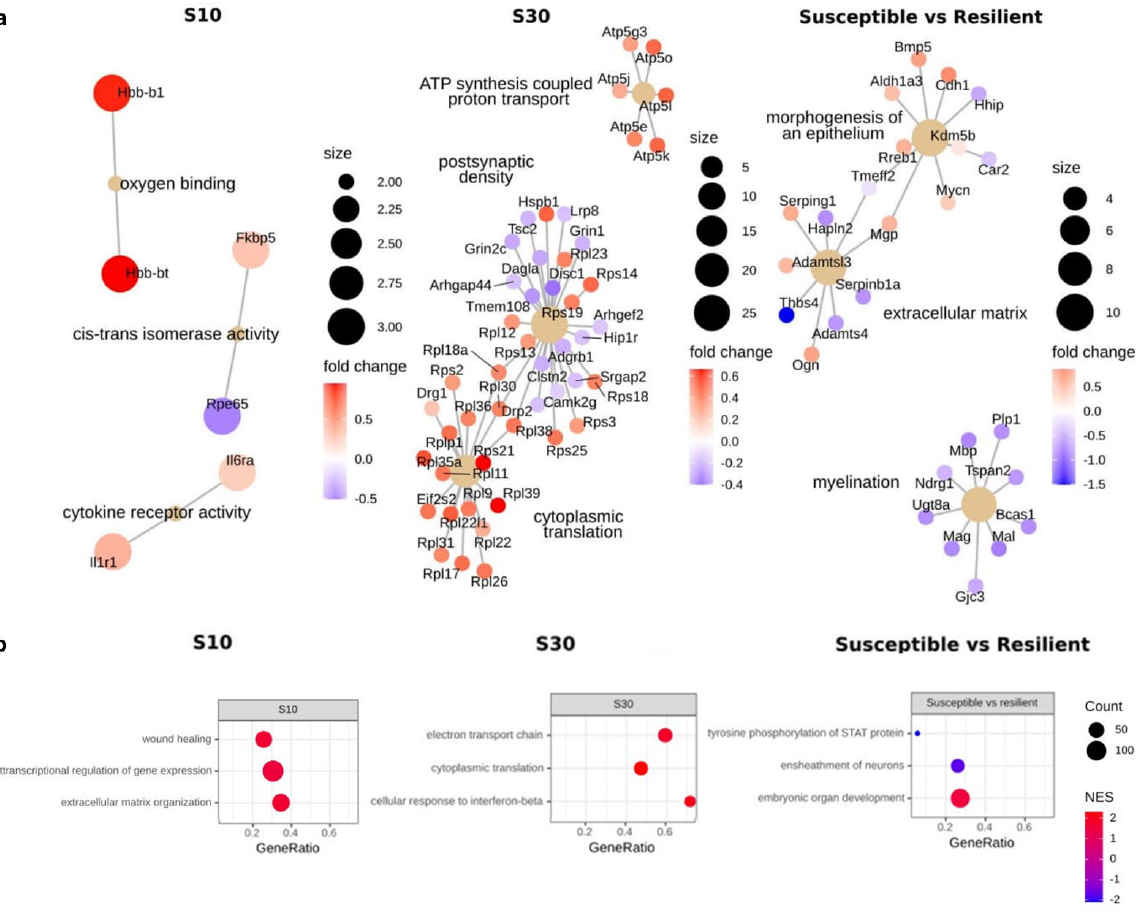
Figure 3. Functional annotation and GSEA of genes. ( a ) Top three most significant GO terms enriched in a set of DEGs (p.adj < 0.05) in different groups. ( b ) Top three most significant GSEA categories among all expressed genes (FPKM > 0.1) in different groups.